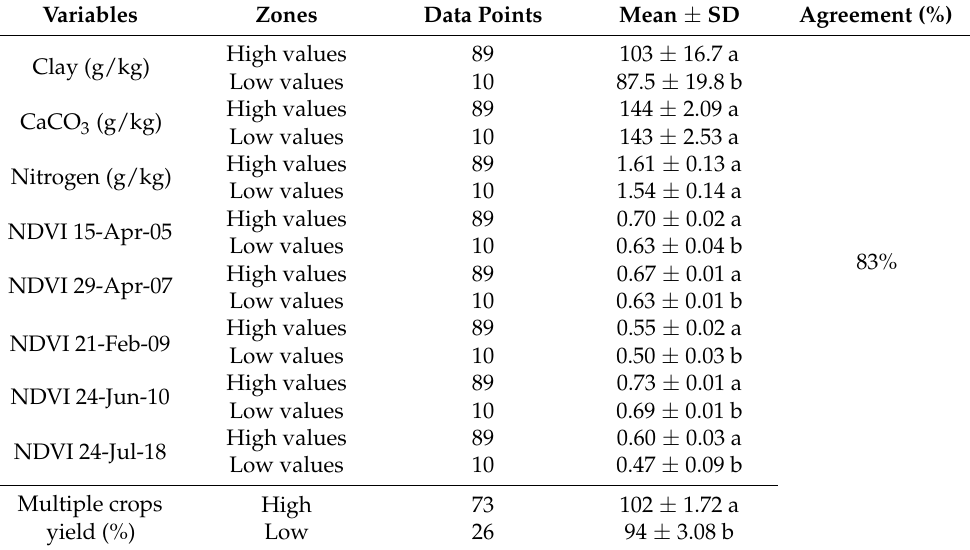
Figure 7 . Two-zone multiple soil and NDVI map, ( a ); two-zone multiple crops yield map ( b ). Table 13. Statistical differences between two-zone multiple soil properties and NDVI indices, and their pixel agreements (percentage) with two-zone multiple crops yield map.